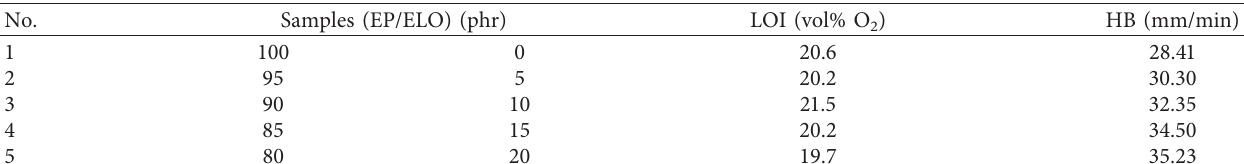
Table 3: Effect of E240/ELO epoxy ratios on mechanical and flame-retardant properties of the materials. No.